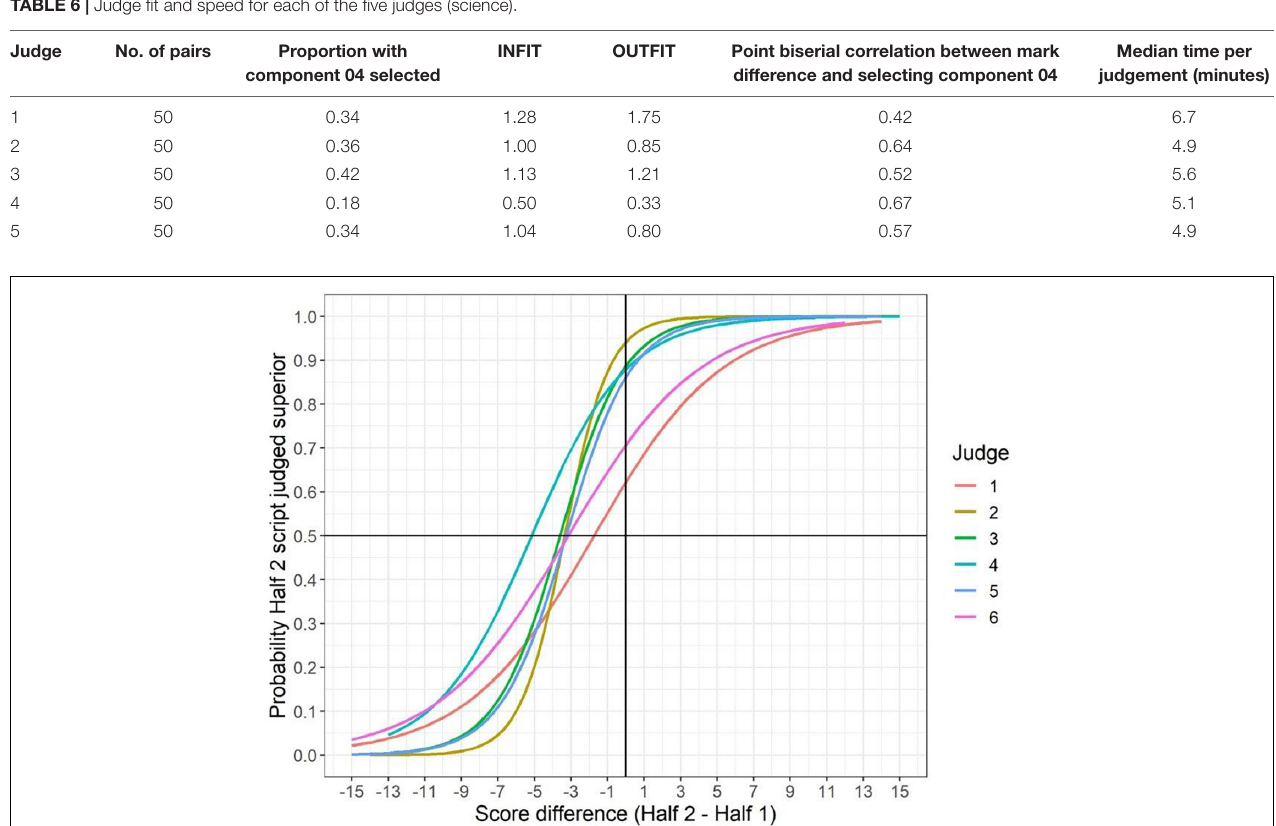
FIGURE 4 | The relationship between differences in marks for a pair and the likelihood of selecting half 2 as superior (by judge).